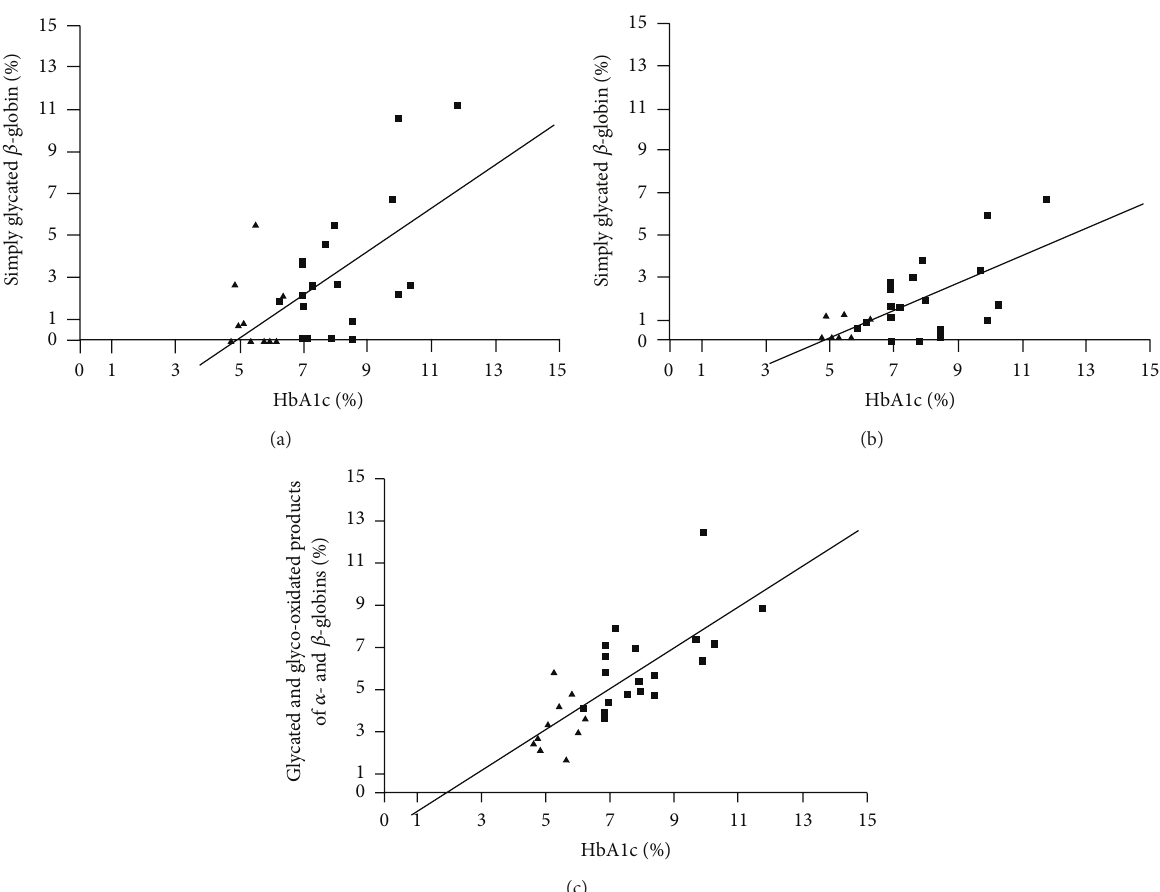
Figure 8: Plots of HbA1c values versus: 𝛽 globin glycation levels (a); 𝛽 + 𝛼 globins glycation levels (b); glycated and glyco-oxidated 𝛽 and 𝛼 globins levels